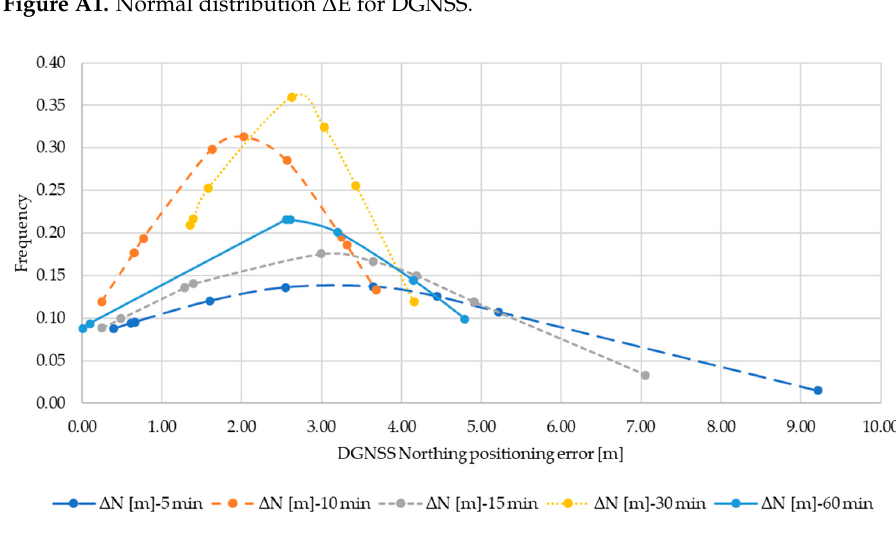
Figure A2. Normal distribution Δ N for DGNSS.